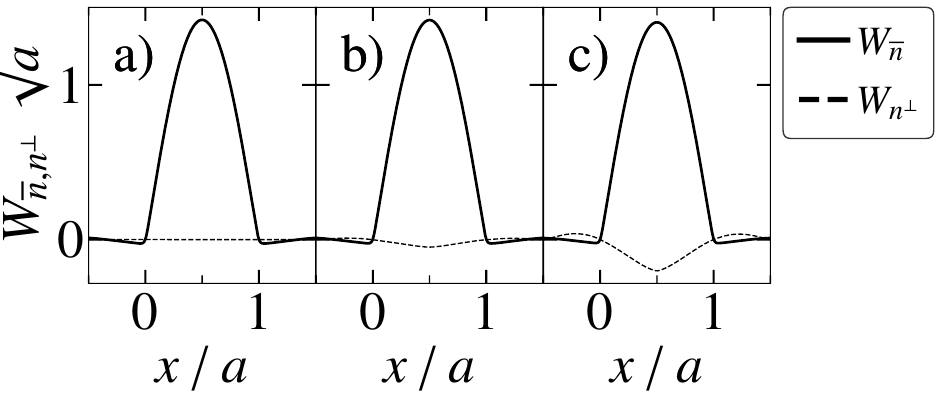
( x ) (solid lines) and W Figure 13: Wannier functions W ¯ n n = 1 centered at x = a / 2 for the first energy band. Parameters are ε = 0.1, Ω = 8000 E , ∆ = Ω and a) α = 0, b) α = 15 ◦ , c) α = 30 ◦ p R p